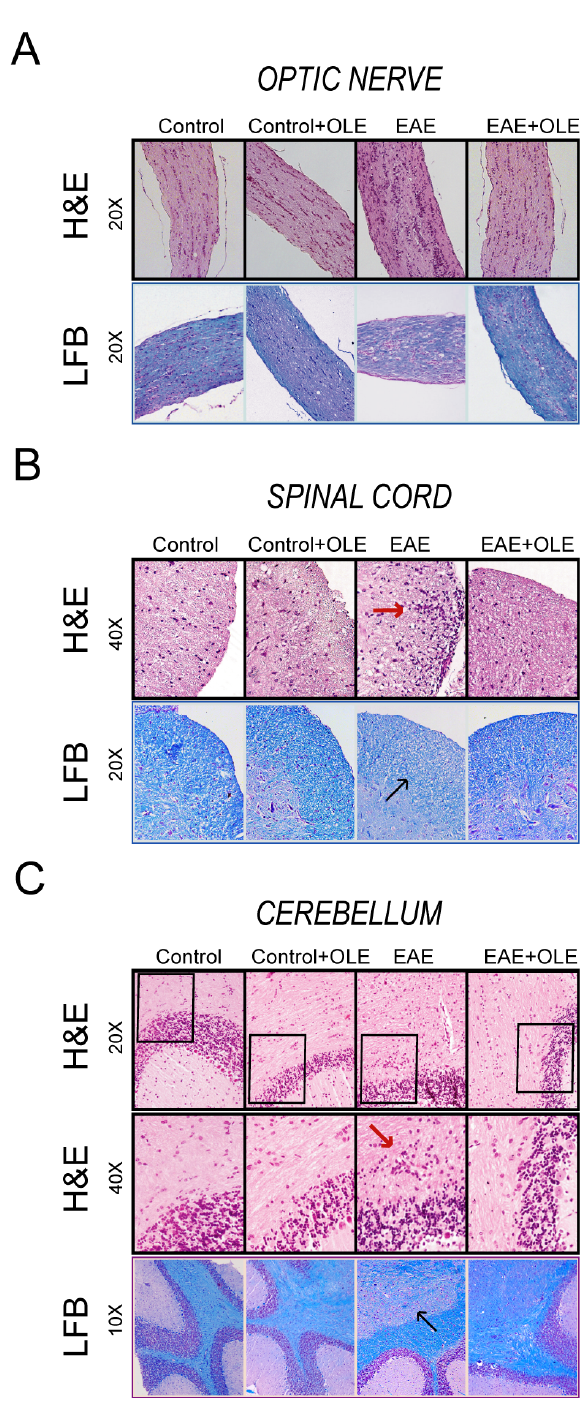
Figure 2. Oleacein treatment protects EAE mice from infiltration of inflammatory cells into central nervous system (CNS) and demyelination. Optic nerve ( A ), spinal cord ( B ) and cerebellum ( C ) from healthy-control and EAE mice treated with vehicle or OLE were removed on day 23 after induction and stained in with H&E in the upper panels or Luxol Fast Blue (LFB) in the lower ones. Representative sections are shown ( n = 5/group, from two independent experiments.). Red arrows indicate infiltration and blue arrows indicated area of demyelination.